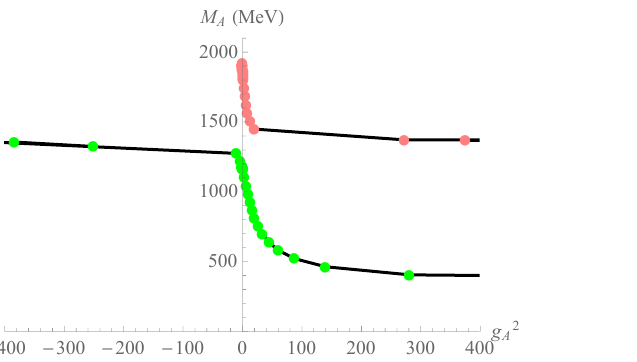
Figure 5. The masses of the pseudovector meson ground state and first excited state as a function of g 2 A